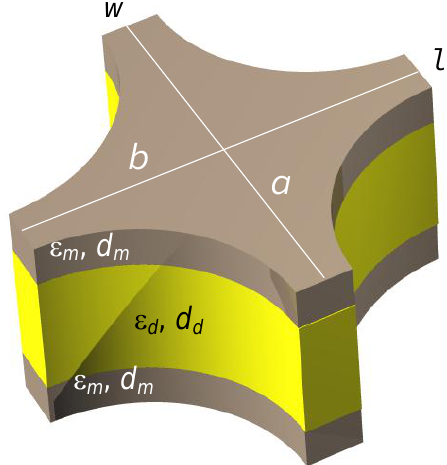
Figure 10. A unit cell of a double fishnet structure with circular apertures. The basic parameters of the structure are denoted in the picture. The permeability of the both constituents is equal to